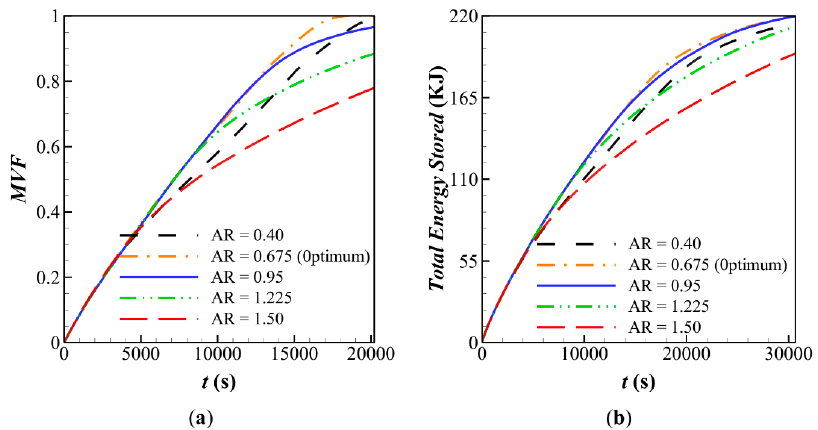
Figure 13. The effect of the radius aspect ratio ( AR ) on the characteristic parameters when VF na = 0.04 and α = 0 for: ( a ) Melting volume fraction; ( b ) Total energy stored as a function of time for different values of AR (radius ratio).